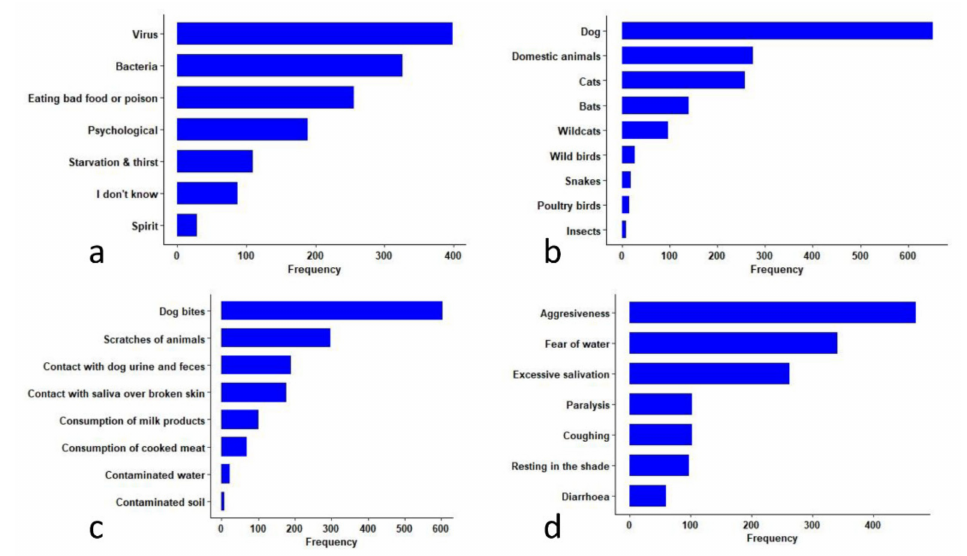
Figure 3. Knowledge on rabies among the students from study areas in South Bhutan: ( a ) knowledge on causes of rabies mentioned by the students; ( b ) knowledge on the susceptible hosts of rabies mentioned by the students; ( c ), knowledge on the mode of transmission of rabies mentioned by the students; and ( d ) knowledge on the clinical signs of rabies mentioned by the students. Each bar in the graph represents frequency of the positive responses by total students who heard about rabies ( n = 688) to the specific cause, hosts, routes, and clinical signs of